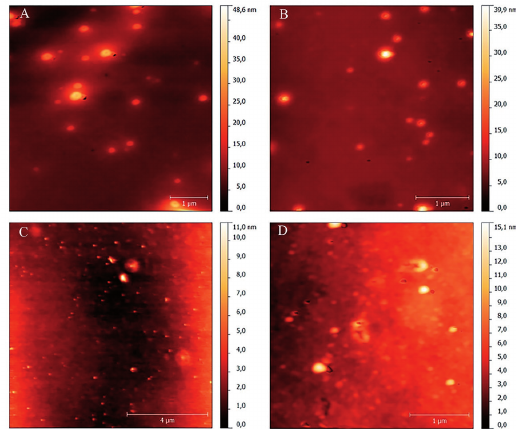
Figure 4: AFM images of the topography of self-assembled nanoparticles after filtration through 0.45 μm membranes: (A) PEO - b -PLA ; (B) PEO - b -PLA containing 10% 5KDa 4.5KDa 5KDa 4.5KDa lavender essential oil; (C) PEO - b -PLA ; (D) PEO - b - 5KDa 10KDa 5KDa PLA containing 10% lavender essential 10KDa